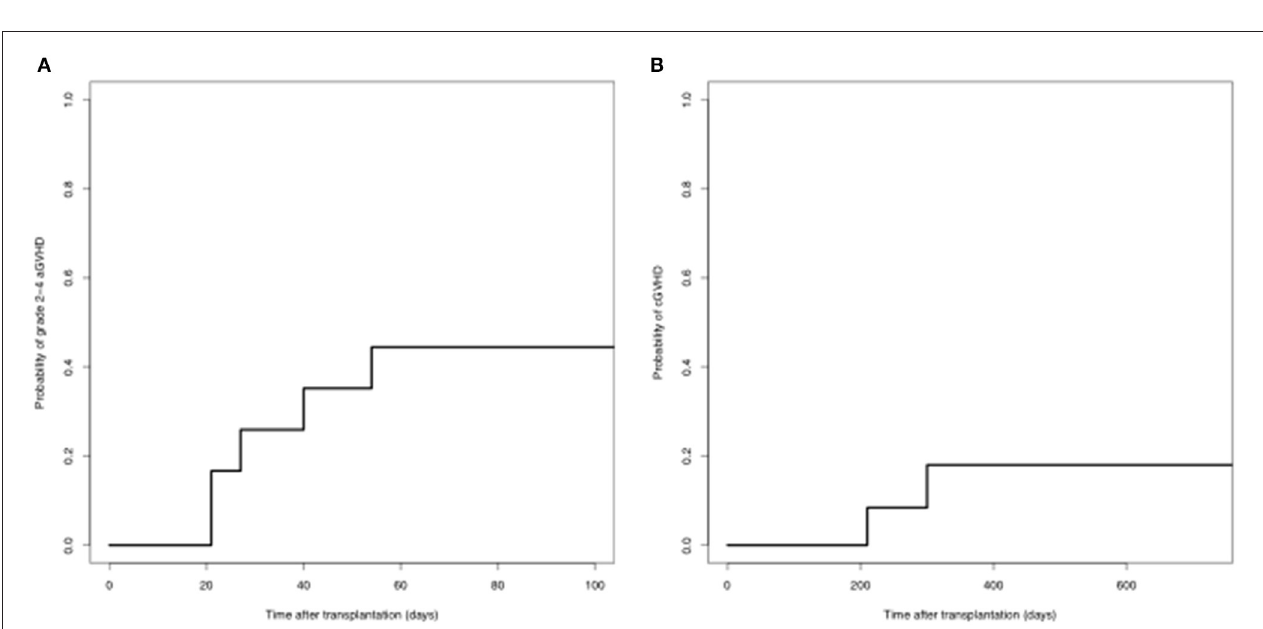
FIGURE 1 | Engraftment (A) neutrophil engraftment; (B) platelet engraftment.